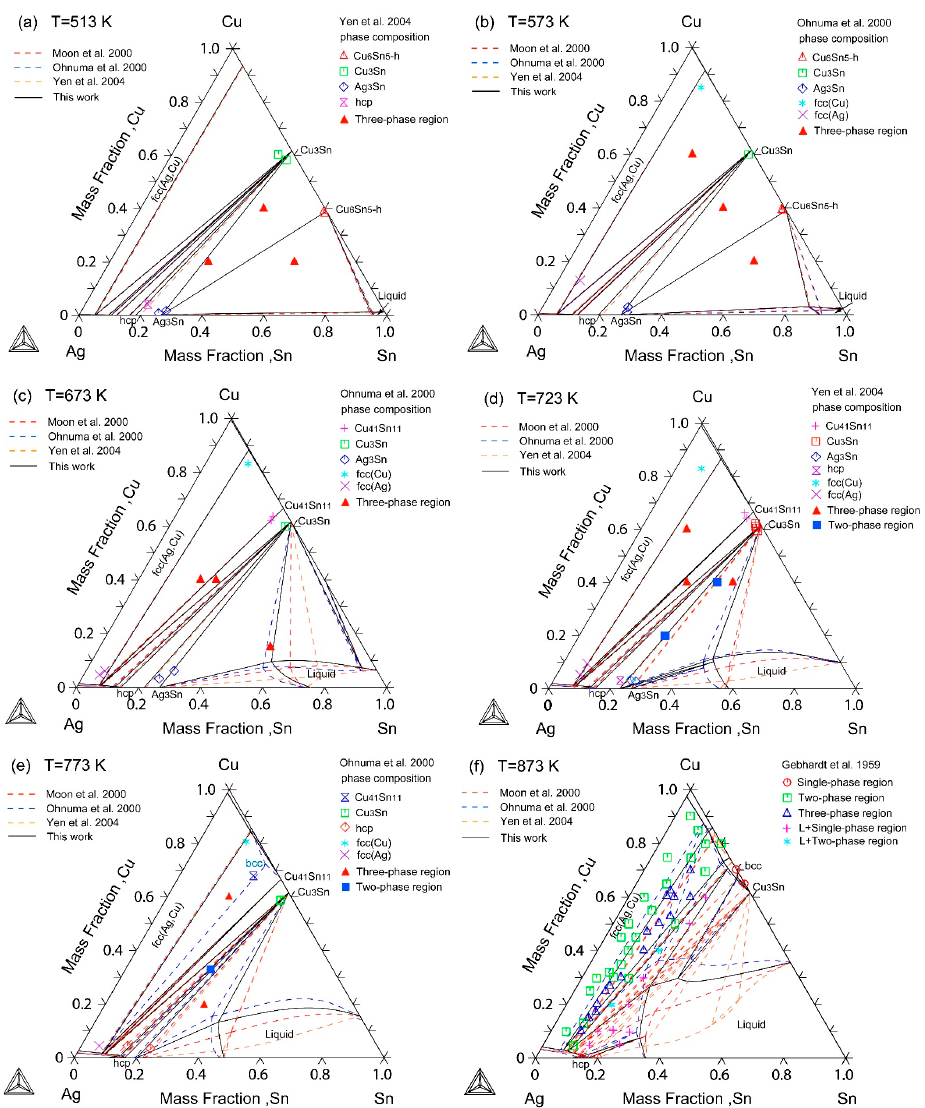
Figure 4. Calculated isothermal sections of the Ag-Cu-Sn ternary system at different temperatures with the experimental data from [18,24,25] and the calculated results from [21,24,25]. ( a ) 513 K; ( b ) 573 K; ( c ) 673 K; ( d ) 723 K; ( e ) 773 K; ( f ) 873 K. Figure 5 is the calculated vertical sections with different molar ratios ( 𝑥 (cid:3002)(cid:3034) :𝑥 (cid:3004)(cid:3048) = 1 , 𝑥 (cid:3002)(cid:3034) :𝑥 (cid:3020)(cid:3041) = 1 , 𝑥 (cid:3004)(cid:3048) :𝑥 (cid:3020)(cid:3041) = 1 , 𝑥 (cid:3002)(cid:3034) :𝑥 (cid:3004)(cid:3048) = 7:3 ) with the experimental results [26,27] and the calculated results [21,24]. The calculated vertical section of 𝑥 (cid:3002)(cid:3034) :𝑥 (cid:3004)(cid:3048) = 1 in Figure 5a is in